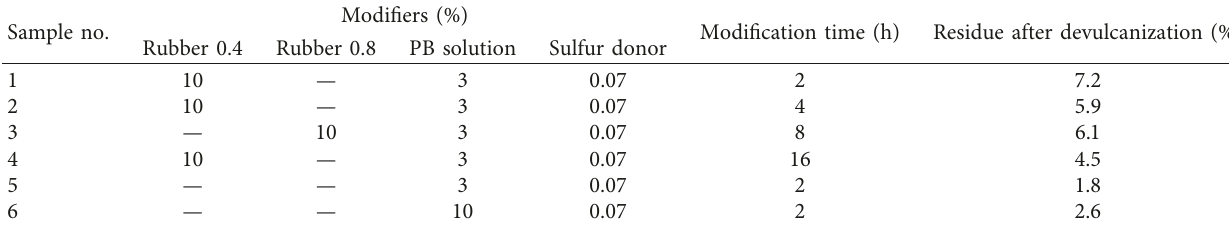
Table 1: Bitumen modification at 190 ° C.